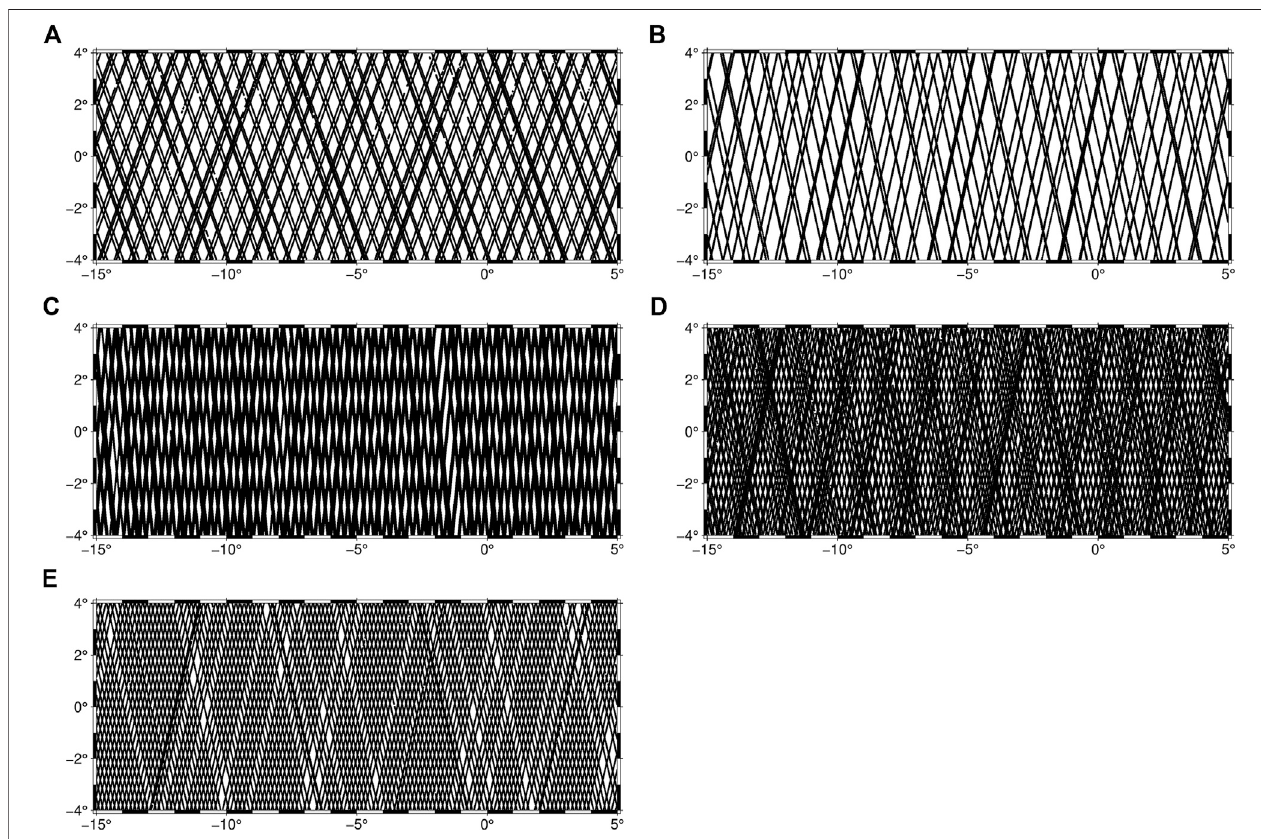
FIGURE 1 | Ground tracks of (A) Jason-1/GM, (B) Envisat, (C) Cryosat-2, (D) SARAL/AltiKa, and (E) HY-2A/GM.